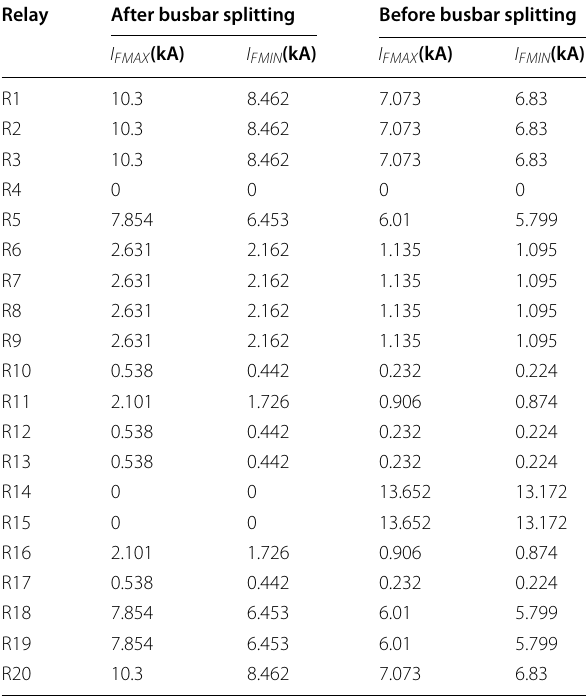
Table 3 Minimum and maximum fault current observed by each relay in the IEEE 14-bus sytem Relay After busbar splitting